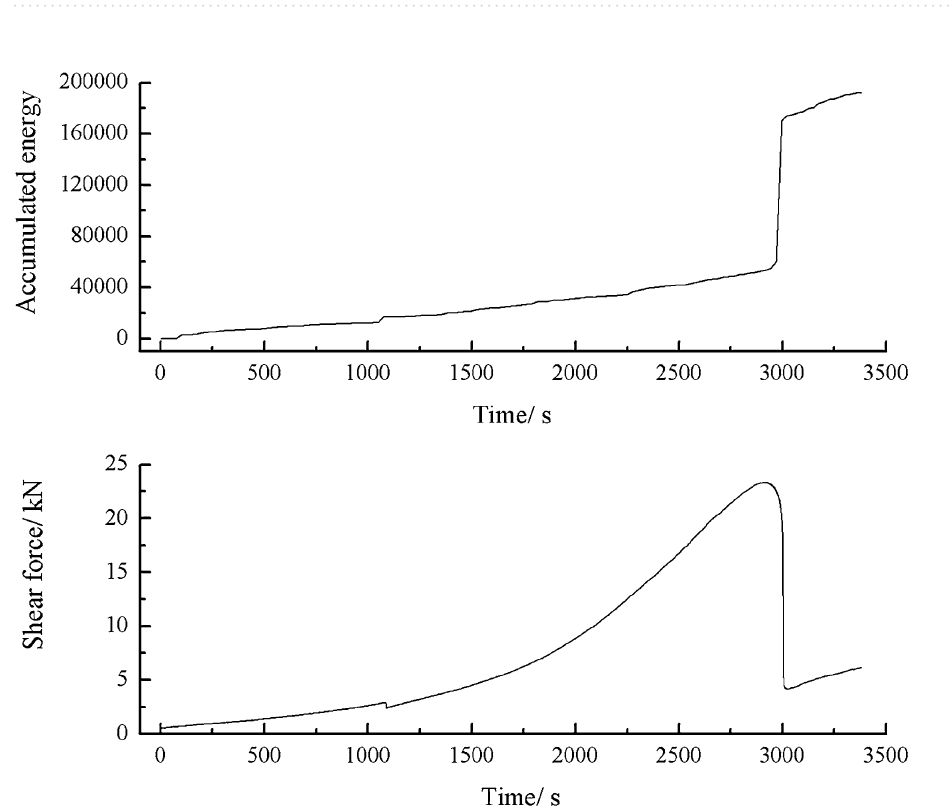
Figure 59. Shear stress–time and cumulative energy-time curves for a specimen containing 0–2.56 mm sand particles (produced from three grain size